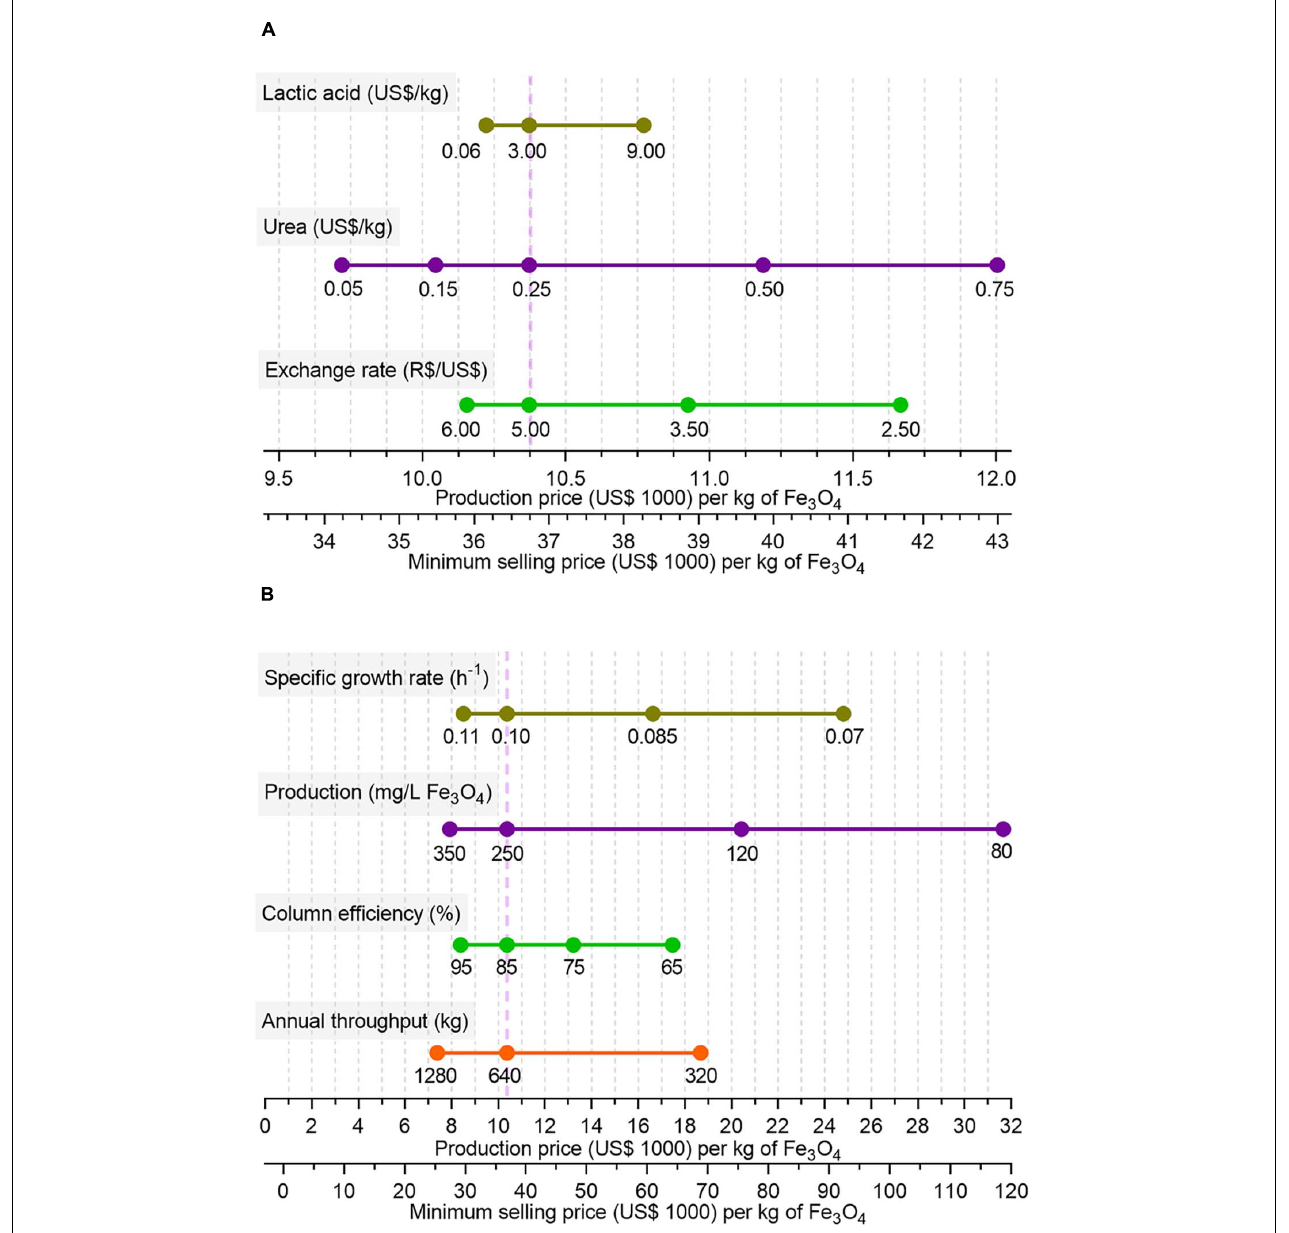
FIGURE 6 | Sensitivity analyses showing effects of variations in market (A) and bioprocess-related parameters (B) on unitary production costs and minimum selling prices (MSP) for the single-stage process, when one of those individual parameters oscillate from the base-case (purple dashed vertical line). The results of variations in purchase price of two important feedstocks (lactic acid and urea) and fluctuations of the exchange ratio on the final production price are analyzed in panel (A) . The effects of specific cell growth rate of Ms. gryphiswaldense MSR-1 in fermentation tanks, as well as its magnetite production rate, are analyzed in panel (B) . The efficiency in BMN extraction by the MSCs and the plant annual throughput capacity, in terms of total produced magnetite, are also assessed in panel (B) . The purple dashed vertical line indicates base-case scenario whose parameters are described in Tables 1 , 2